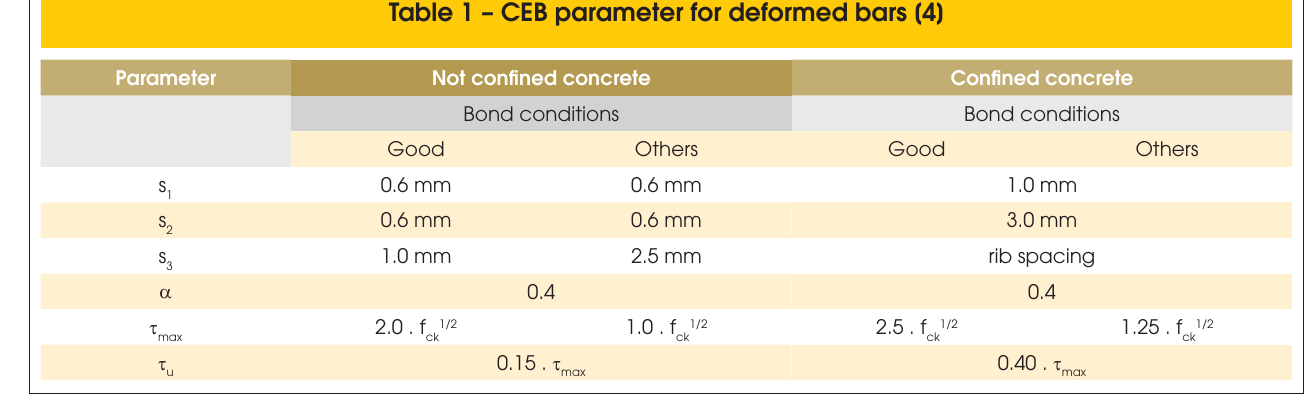
Table 1 – CEB parameter for deformed bars